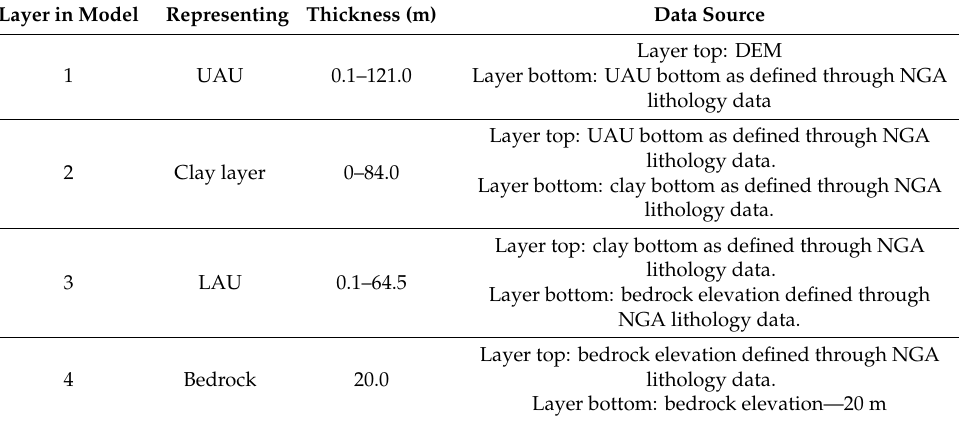
Table 1. Layer arrangement for the numerical model.